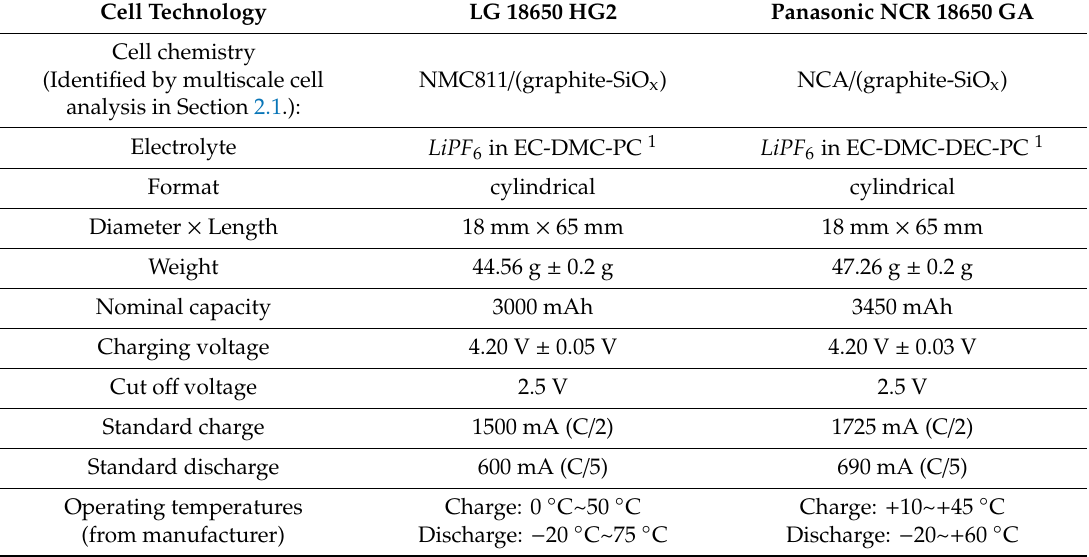
Table 1. Selected Ni-rich commercial batteries.